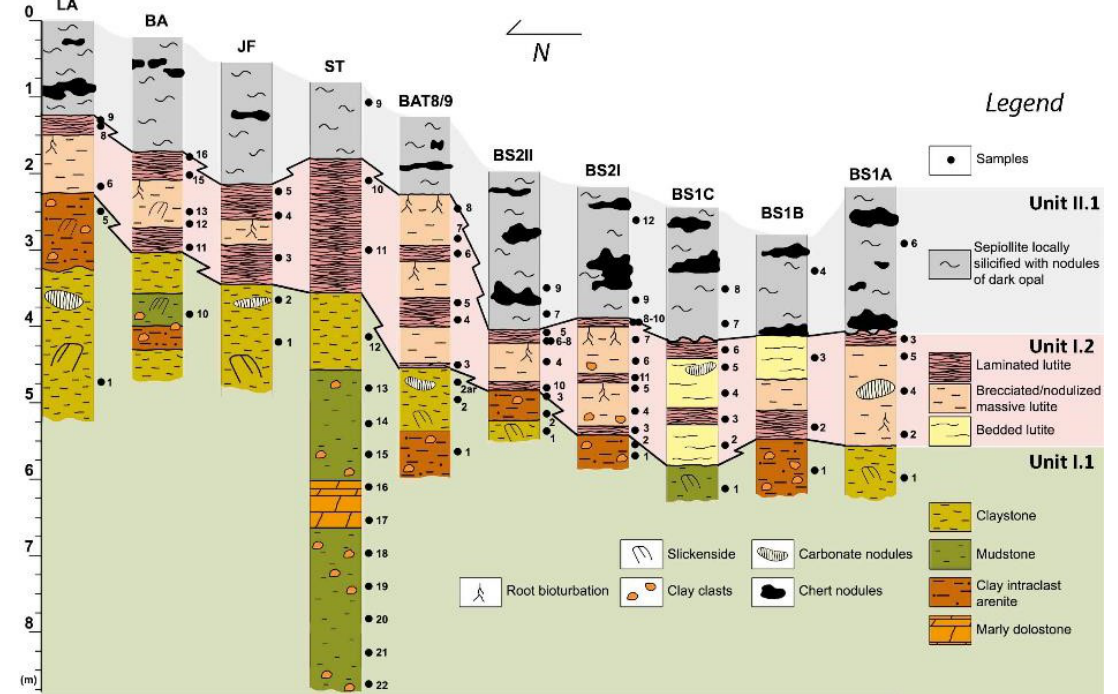
Figure 4. Correlation among lithological logs in the study area. The different units and lithofacies are shown.